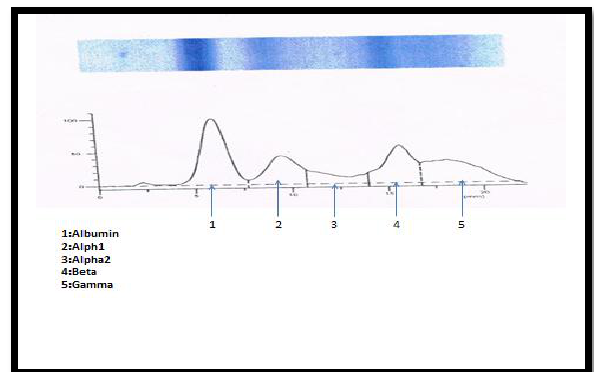
Figure, 2: Serum protein electrophoresis of rats treated with sodium fluoride (SF) (T1).